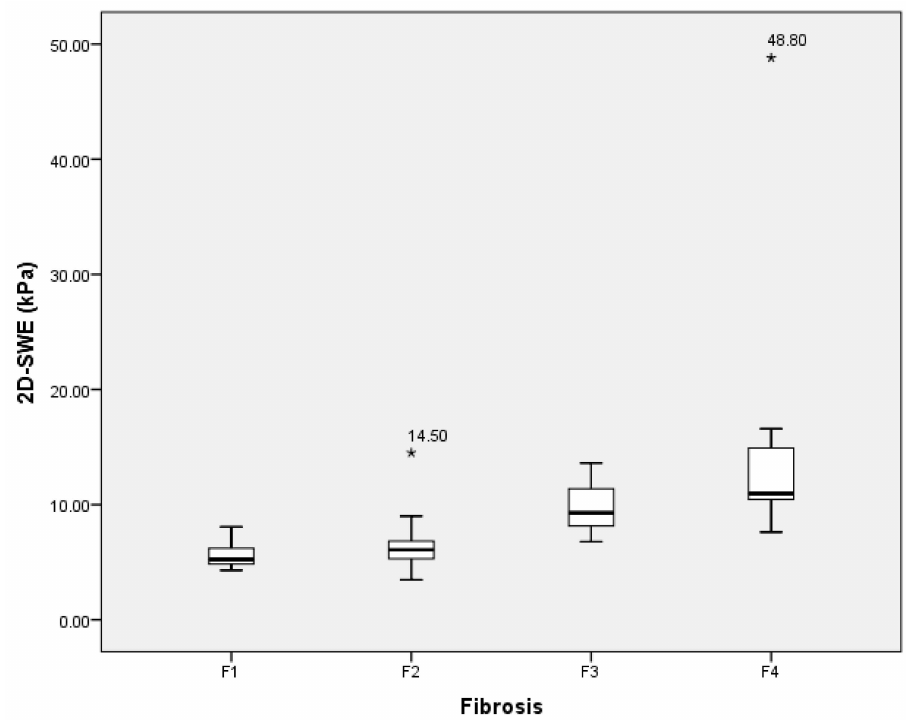
Figure 1. Box plot of the liver stiffness median, measured using 2D-SWE in different liver